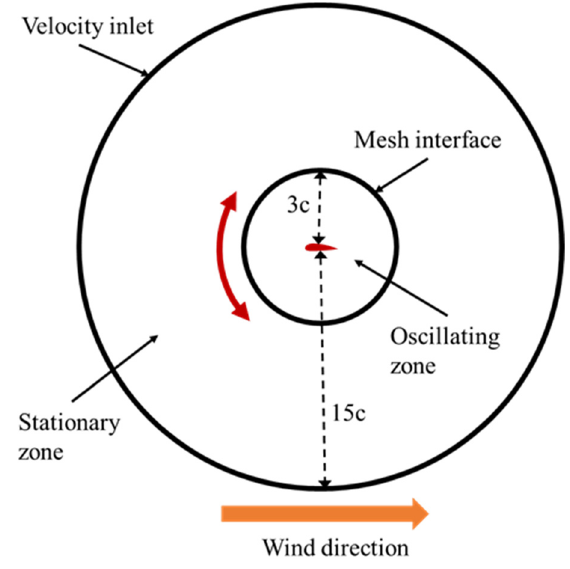
Figure 2. Computational domain specifications.